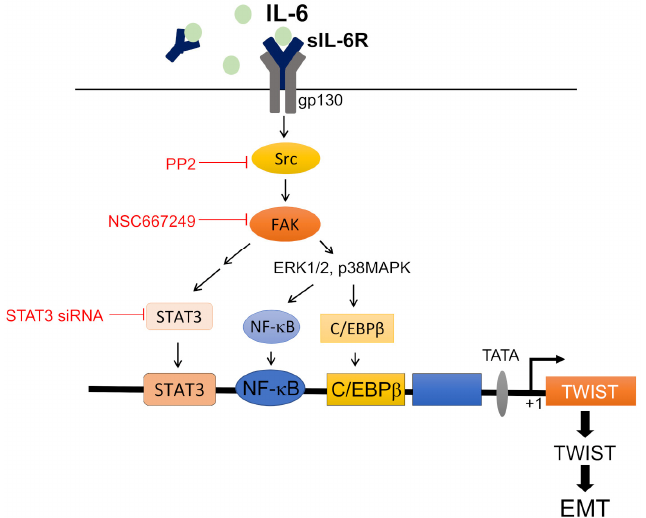
Figure 7. Schematic summary of the signaling cascade involved in IL-6-induced Twist expression and EMT in HCT116 colorectal cancer cells.